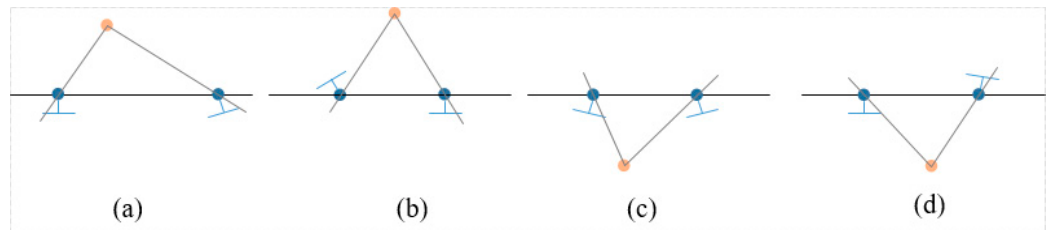
Figure 4. The four possible camera poses.